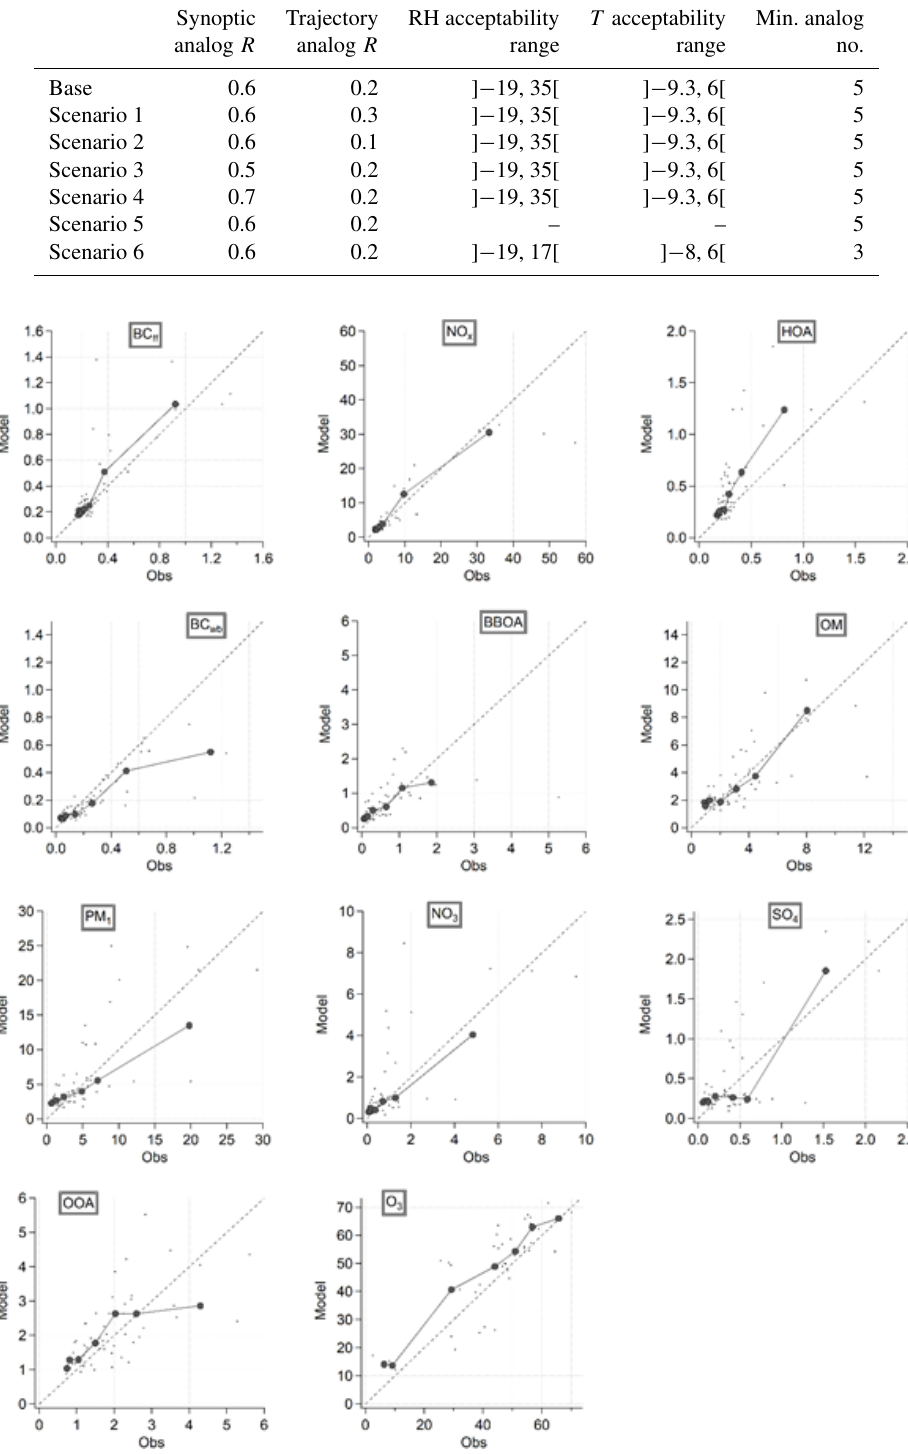
Figure 3. Scatter plots of observed versus estimated concentrations by A 3 Q during the evaluation period of January–February 2020. Dots represent daily values during the evaluation period, and round markers are averages over ranges of observed